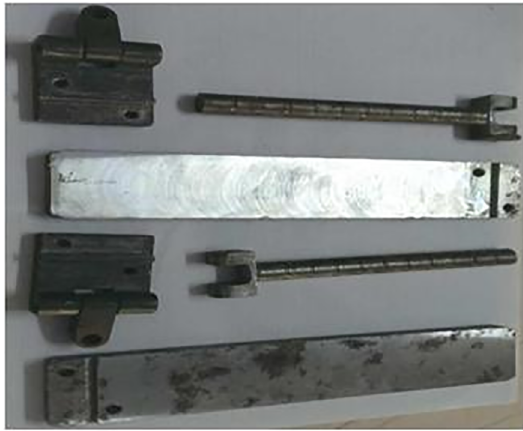
Figure 9. Core shear test fixture.